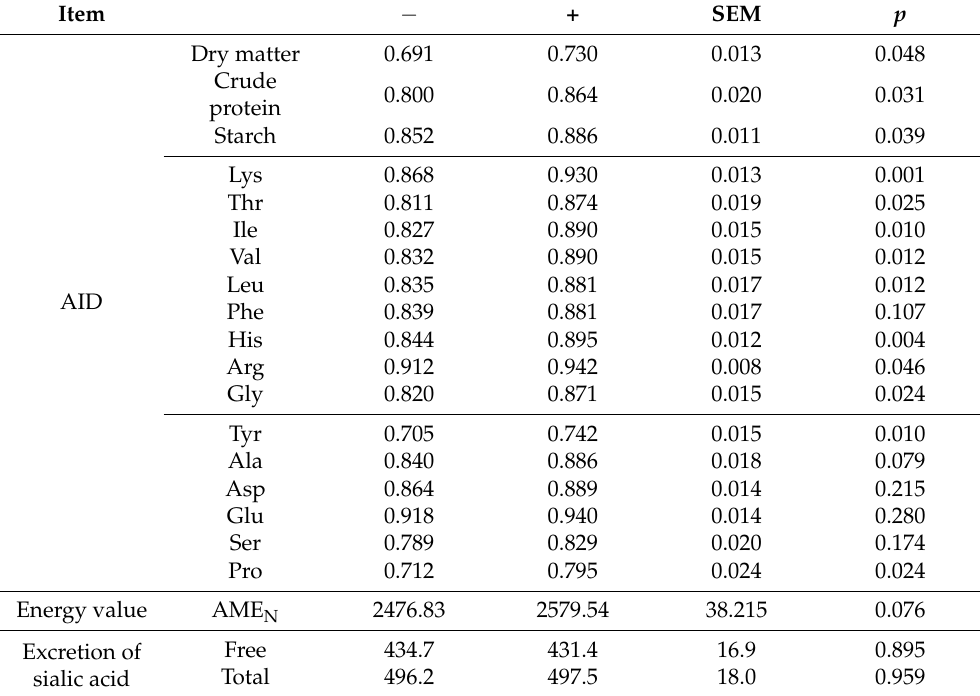
Table 3. Apparent ileal digestibility (AID) of dry matter, crude protein, starch, amino acids, and AME N (kcal/kg) levels, and the excretion of total and free sialic acid (micromol/g TiO 2 ) from broiler chickens fed pea seeds without ( − ) and with (+) enzyme supplementation 1 . Item − +